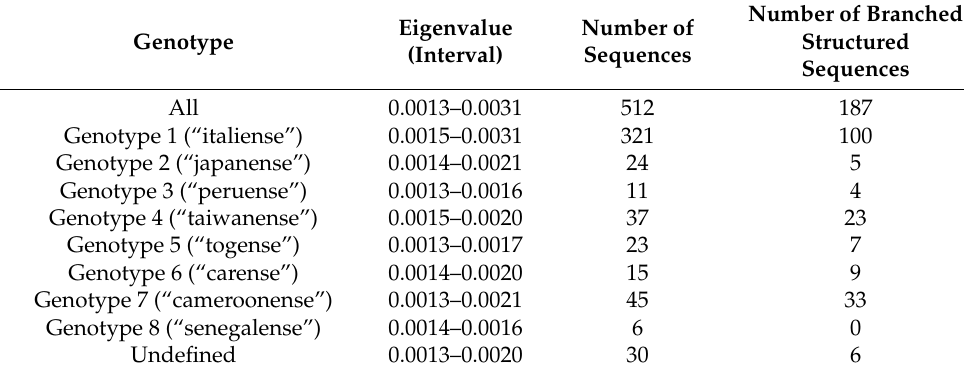
Table 1. Eigenvalue analysis: distribution of the HDV sequences in the various genotypes according to the second-smallest Laplacian